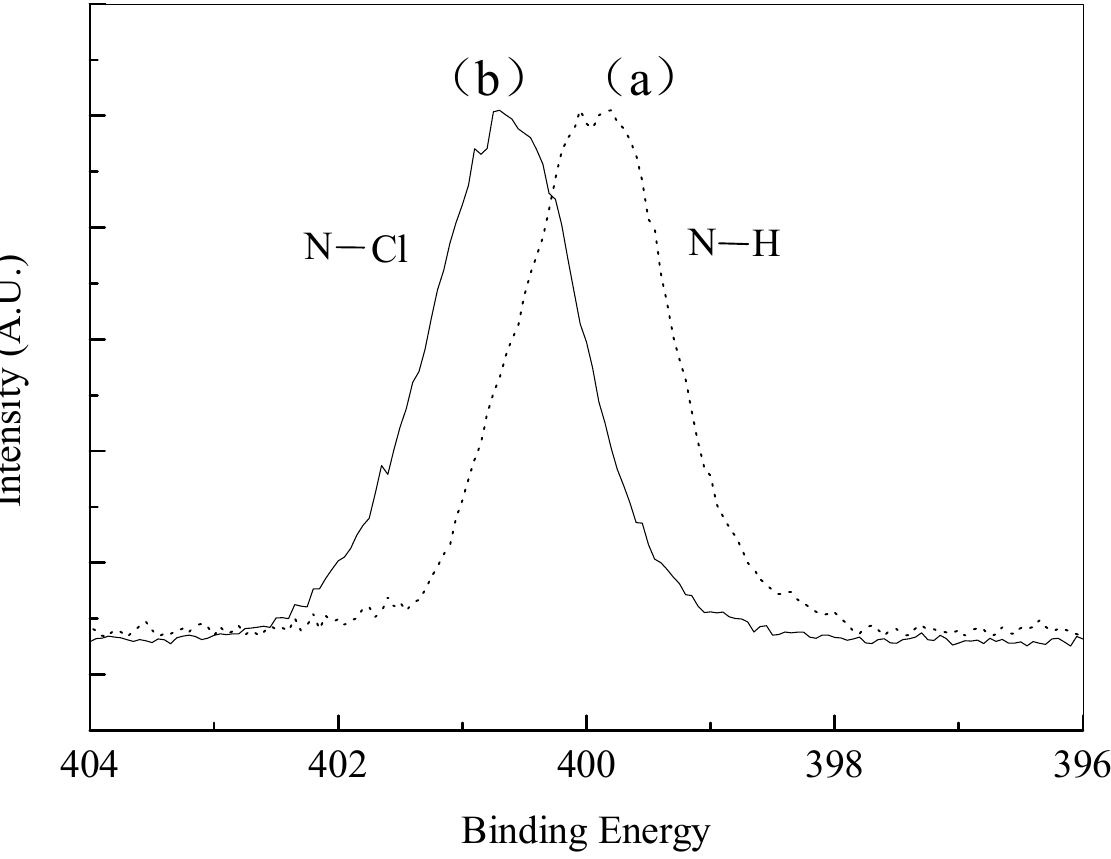
Figure 5. N 1s high-resolution scans of barbituric acid-based polysiloxane@cellulose ( a ) and cyclic imide N -halamine polysiloxane@cellulose ( b ).